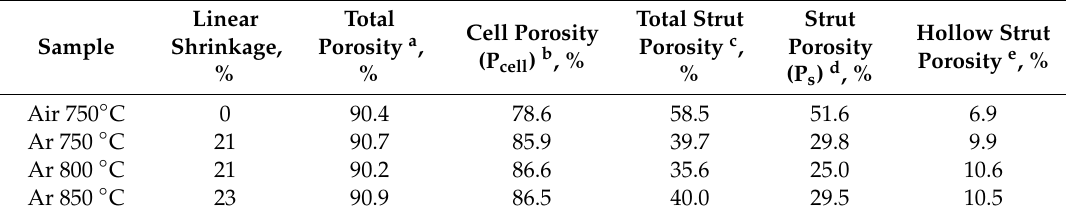
Table 3. Total porosity, open strut porosity, and compressive strength of aluminum foams thermally processed for 3 h at 750 ◦ C in air and at 750–850 ◦ C in